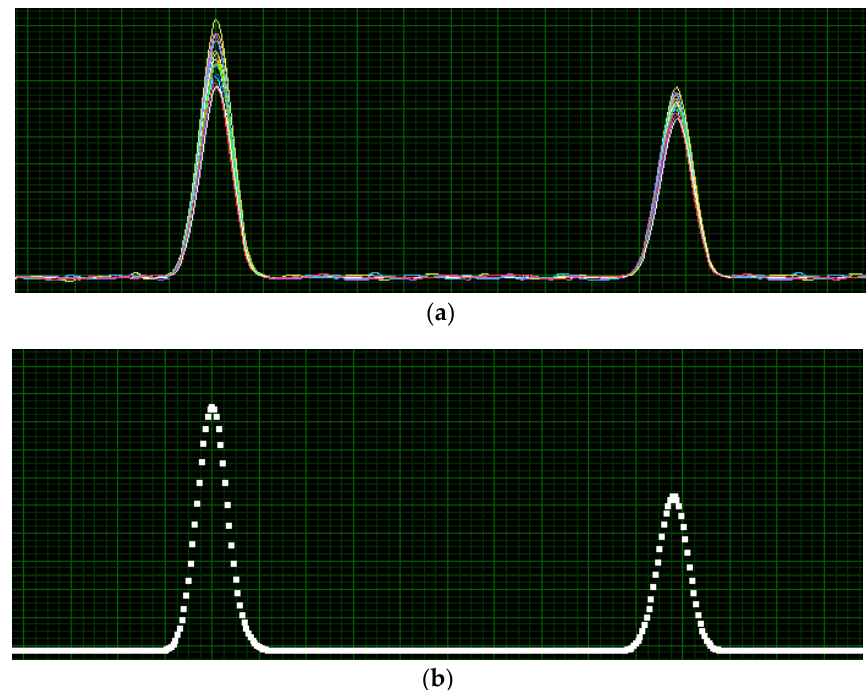
Figure 14. ( a ) Ten subsequent acquisitions, aligned on the first peak. Amplitude scale: 100 mV/division. Horizontal scale: 10 μ m/division; ( b ) Average of the acquisitions from Figure 14a. Amplitude scale: 100 mV/division. Horizontal scale: 10 μ m/division.